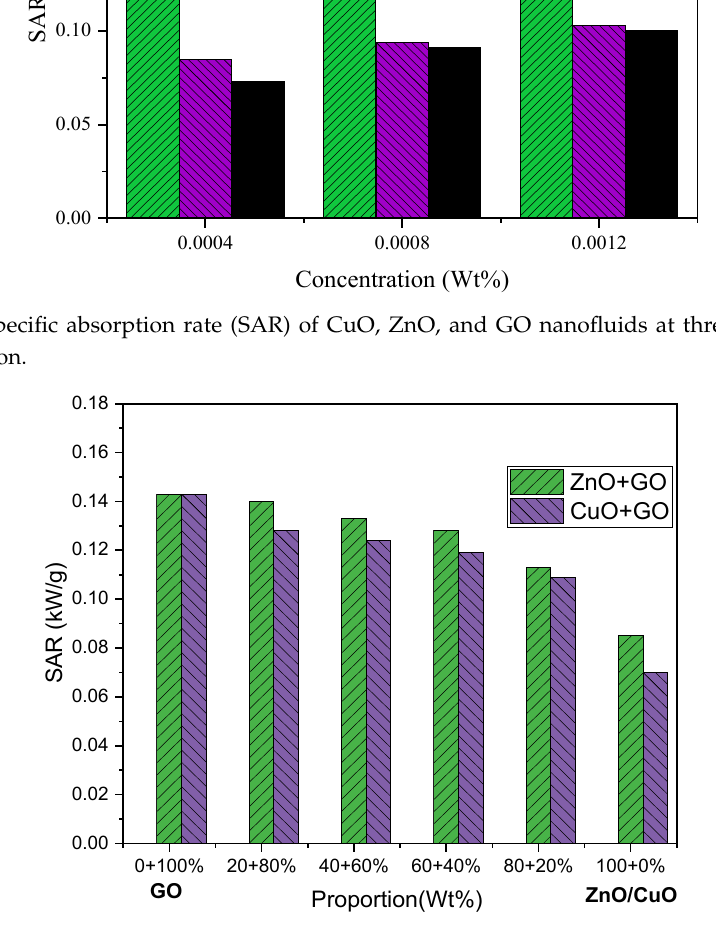
Figure 14. Specific absorption rate of binary nanofluids, ZnO–GO and CuO–GO, at 0.0004 wt % concentrations.